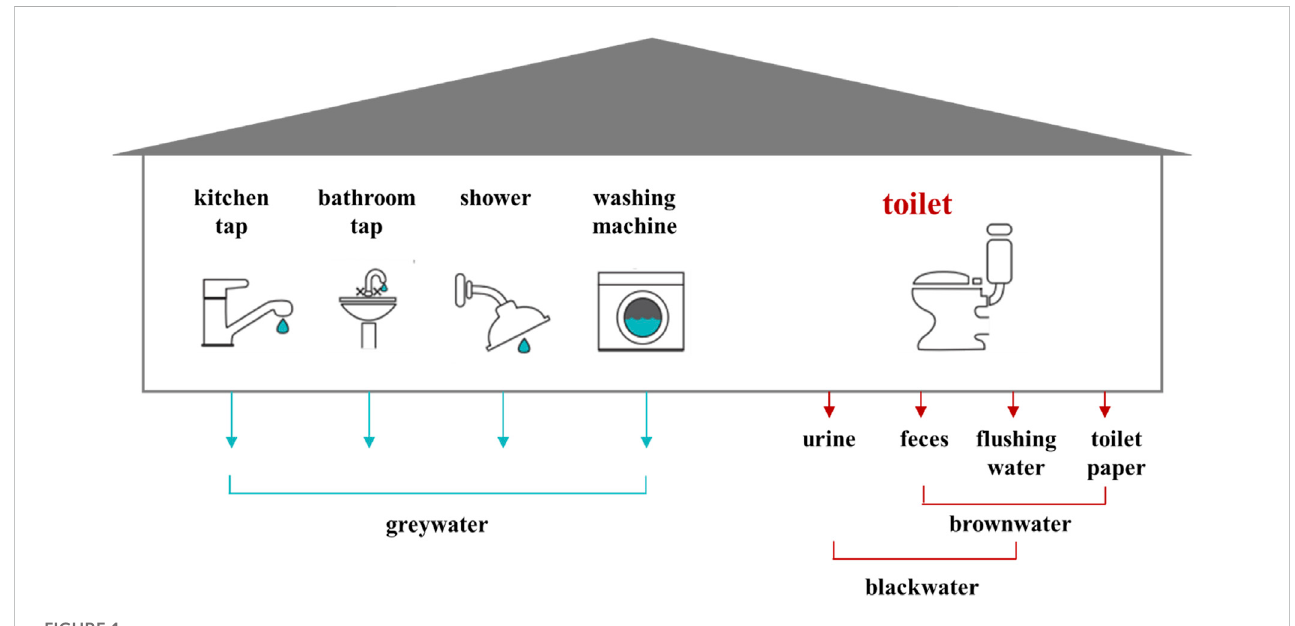
Wastewater in the source separation sanitation system.